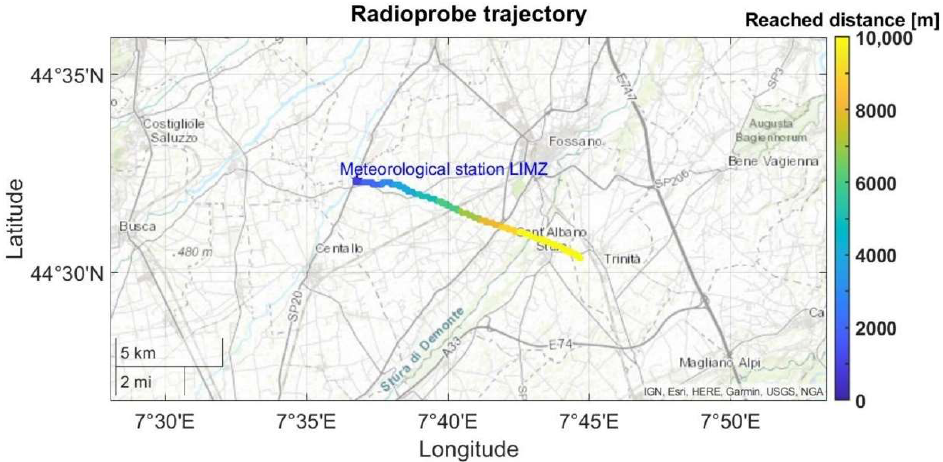
Figure 6. Trajectory of the fully operational radioprobe attached to the reference atmospheric sounding system, displayed on a map. The color bar indicates the separation distance reached by the system with respect to the ground station. Table 3. Results of the point-to-point measurements in open environment (Setup 2).